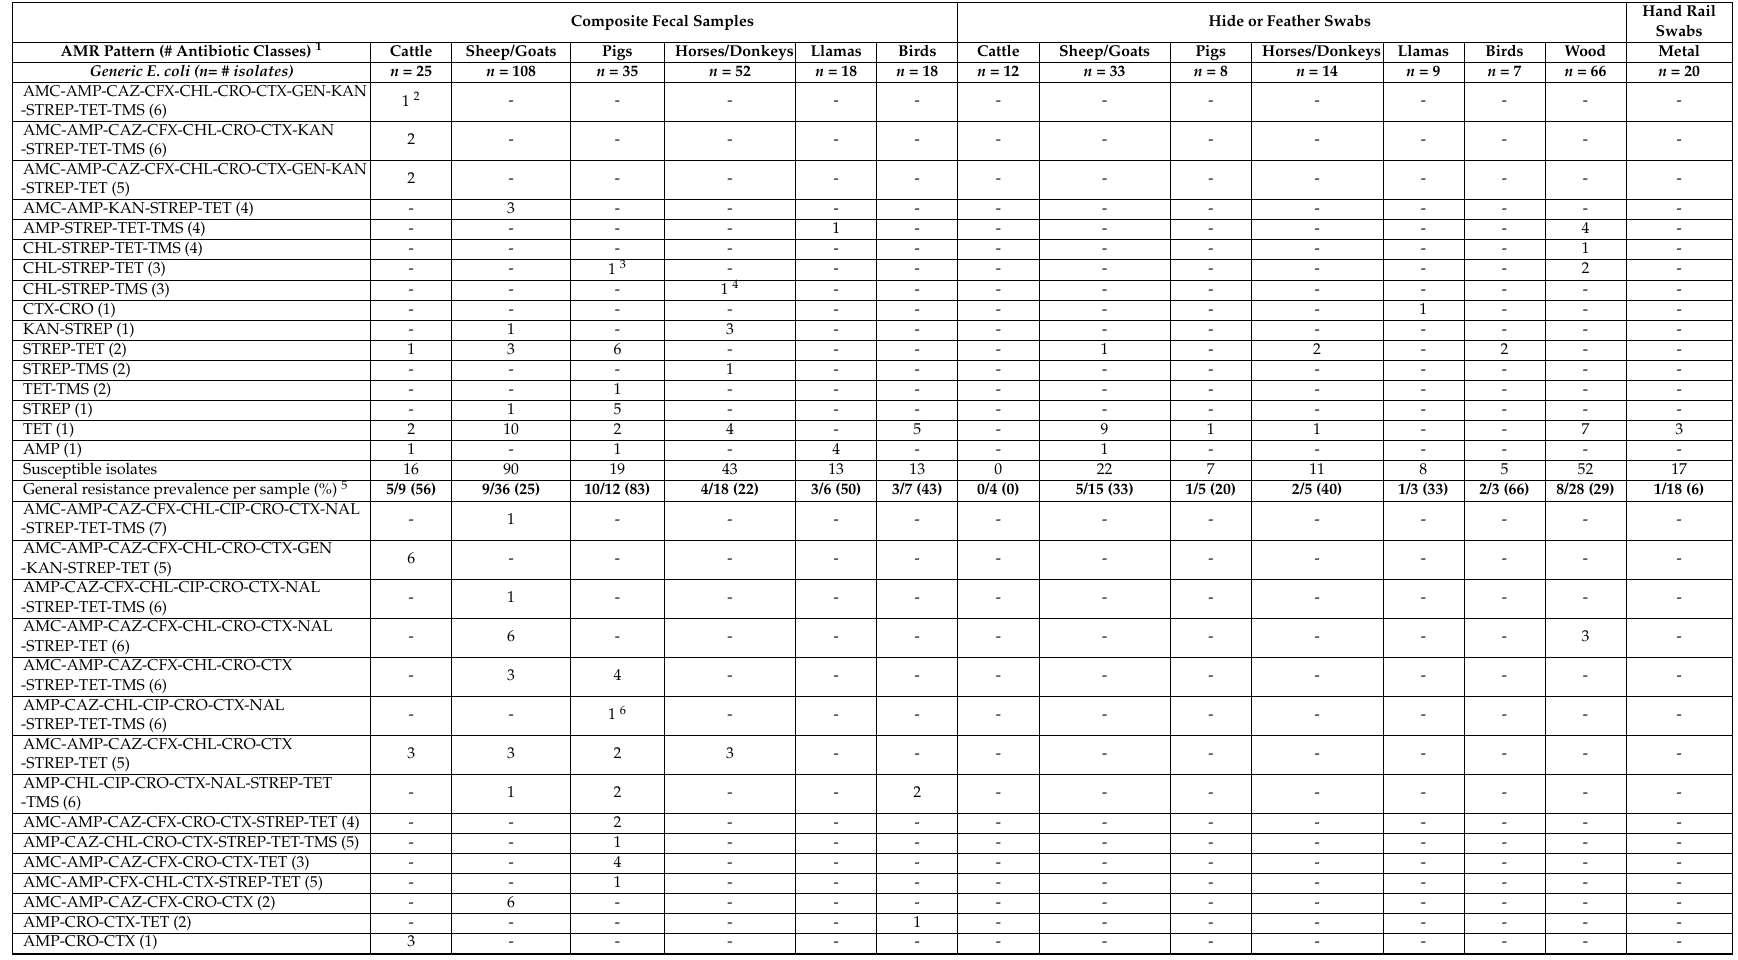
Table 5. Frequency of antimicrobial resistance (AMR) patterns among generic E. coli ( n = 425), broad- and extended-spectrum β -lactamase E. coli ( n = 59), and STEC ( n = 66) isolates from animal feces, hide/feather swabs, and hand